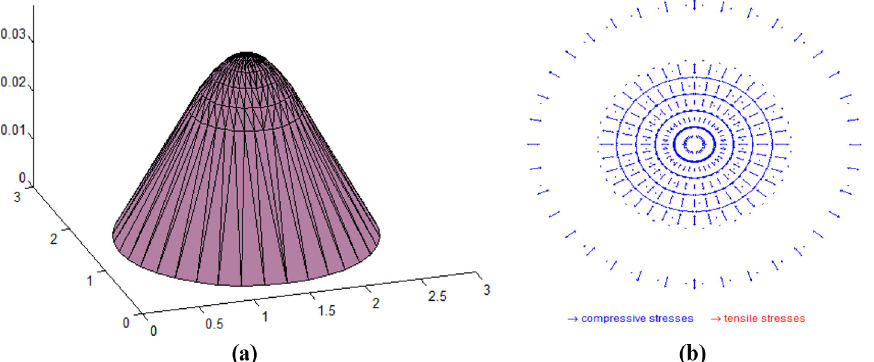
Figure 1. Illustration of a polyhedral stress function (a) and the associated system of planar forces